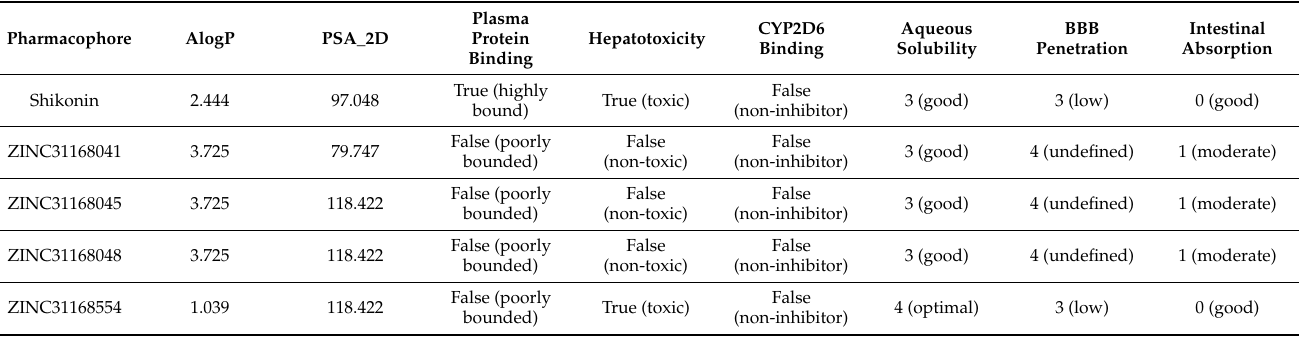
Table 1. Computational parameters of pharmacokinetics (ADME) of Shikonin pharmacophores as calculated by the ADMET Descriptor.